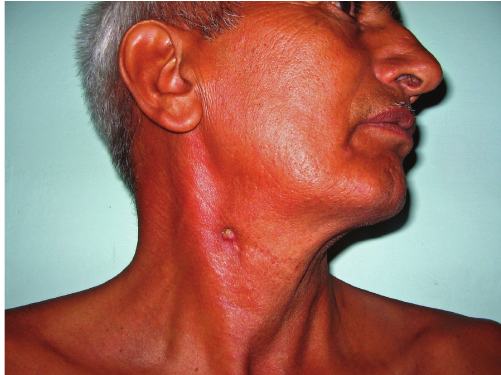
Figure 1: Fistula openining in neck.